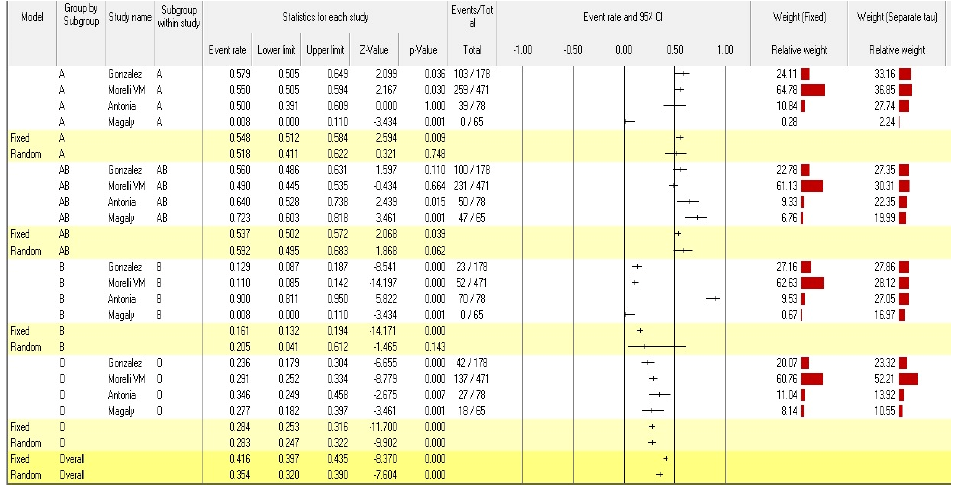
Figure 2. Forest plot from the fixed and random-effects analysis: ABO Blood group susceptibility to venous thromboembolism in individuals with Factor V Leiden [34–37].